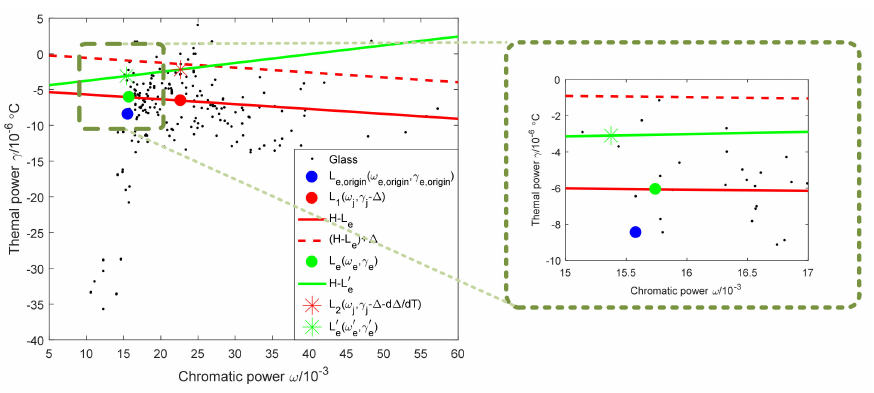
Figure 12. Athermal map of the combination of mirror and housing material as FS + CF.